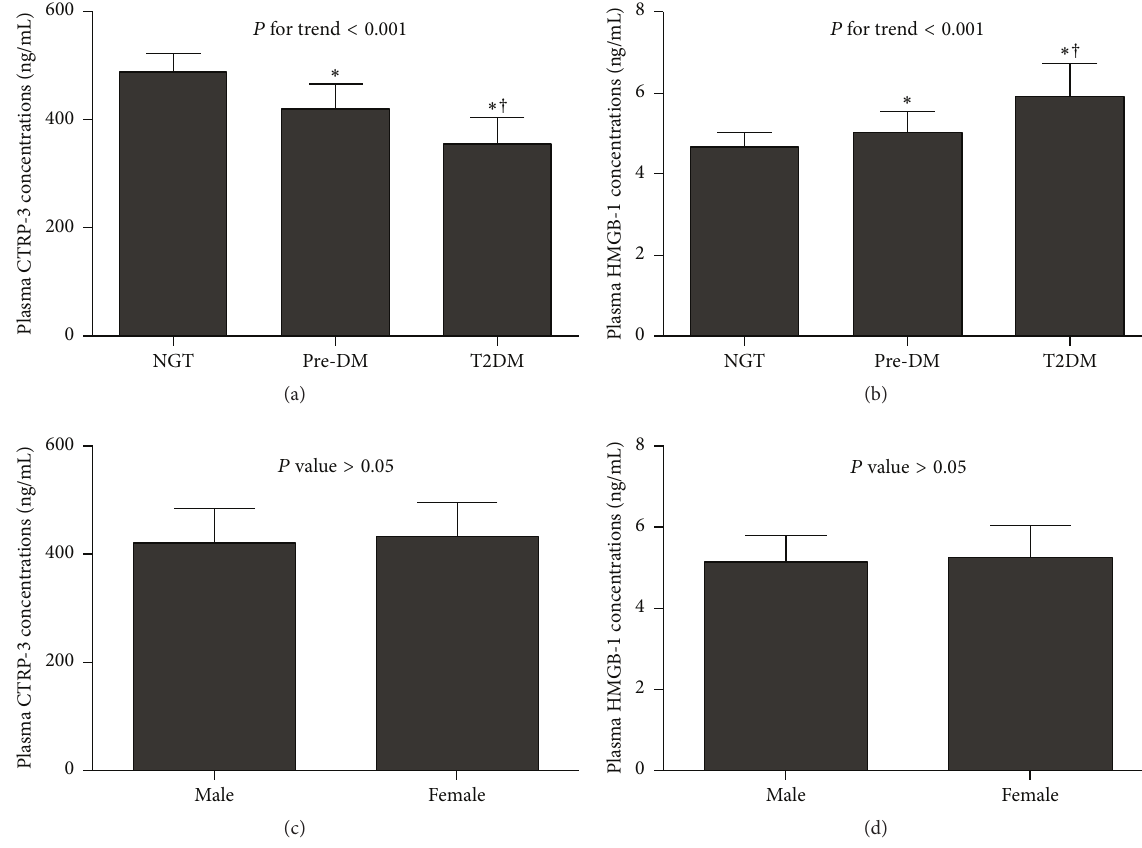
Figure 1: Plasma CTRP-3 (a) and HMGB-1 (b) concentrations in different subgroups and in males and females ((c) and (d)). Data were presented as means ± standard deviation. Differences between multiple groups were tested by analysis of variance (ANOVA) for continuous variables. 𝑃 for trend was estimated by a linear-by-linear association of the chi-square test. ∗ 𝑃 < 0.05 compared with NGT, † 𝑃 < 0.05 compared with pre-DM. CTRP-3, C1q/TNF-related protein-3; HMGB-1, high-mobility group box-1; NGT, normal glucose tolerance; pre- DM, prediabetes states (including IFG, impaired fasting glucose; IGT, impaired glucose tolerance; IGR, impaired glucose regulation); T2DM, type 2